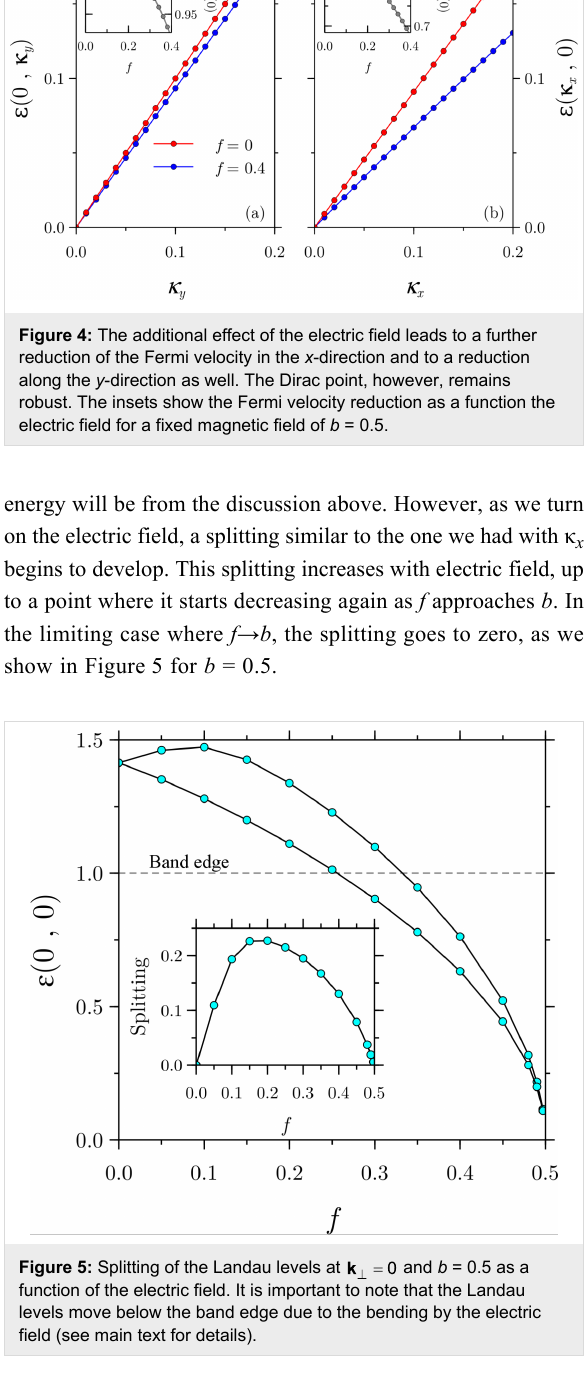
In Figure 5 it may be surprising to see that the Landau bands shift below the band edge, leading to the apparent and erro- neous belief that the latter enter the band gap. The effect of the electric field is to bend the constant band edges shown in Figure 1a upwards due to the presence of the